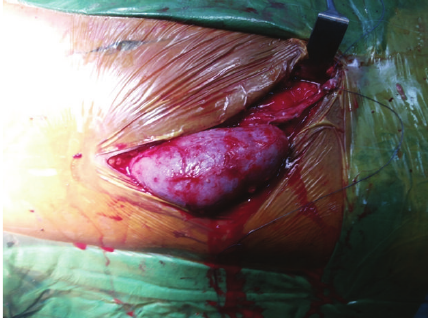
Figure 2: Postoperative image showing well-perfused transplanted kidneys.